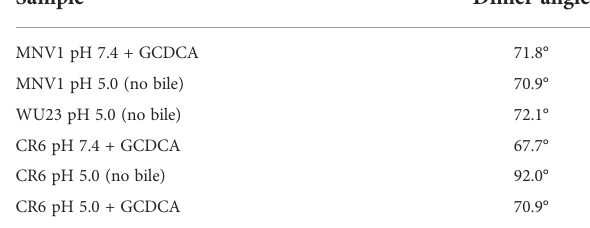
TABLE 2 P domain dimer